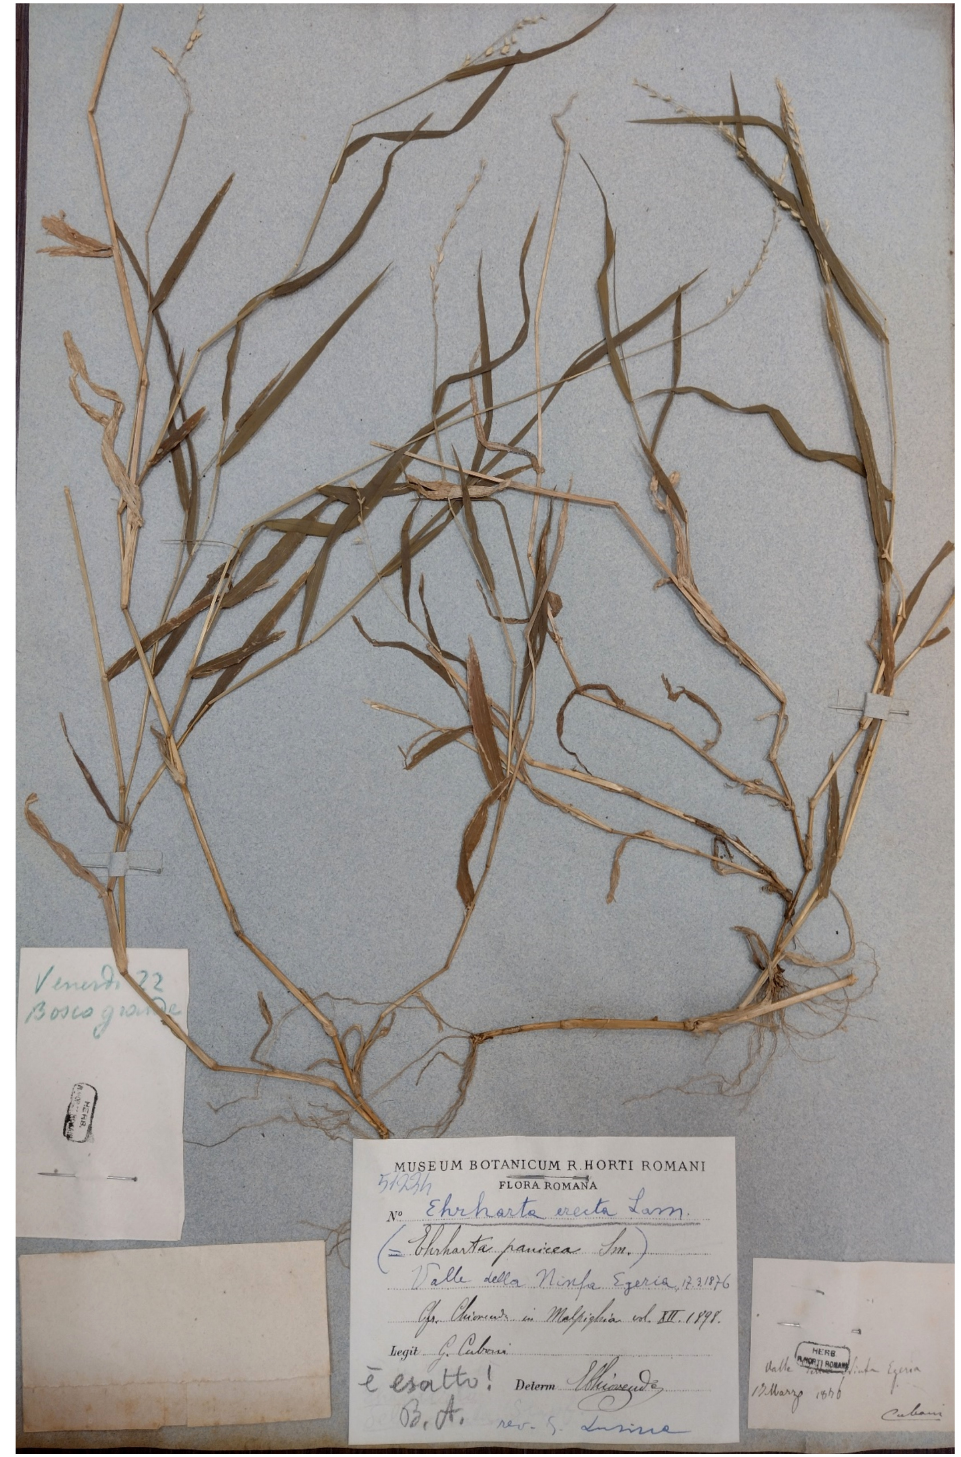
Figure 64. Specimen of Ehrharta erecta collected in Caffarella valley on 17 March 1876 (RO-Herbarium Romano no.